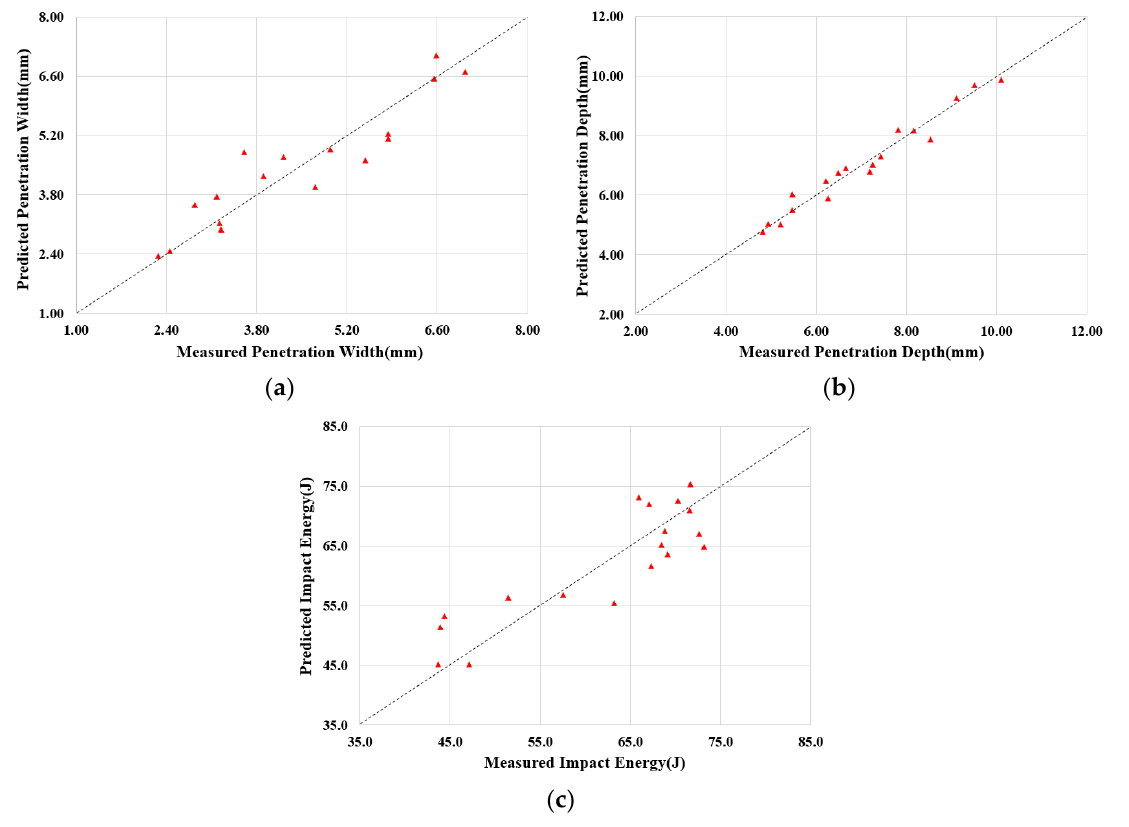
Figure 9. Comparison between measured and predicted welding factors according to mathematical model: ( a ) penetration width, ( b ) penetration depth, ( c ) impact energy. Table 12. Analysis of variance tests for predicted model for welding factors.